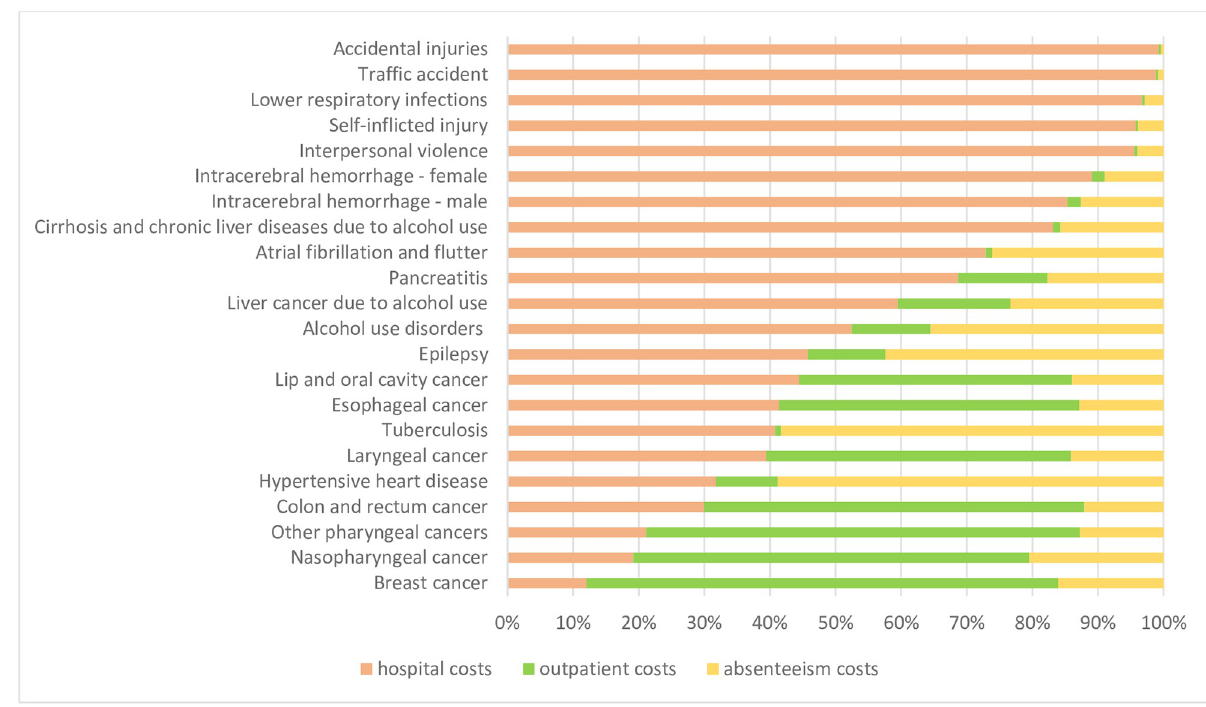
Fig 3. Proportion distribution of cost attributable to alcohol according to ICD and the Brazil information system, 2010–2018.